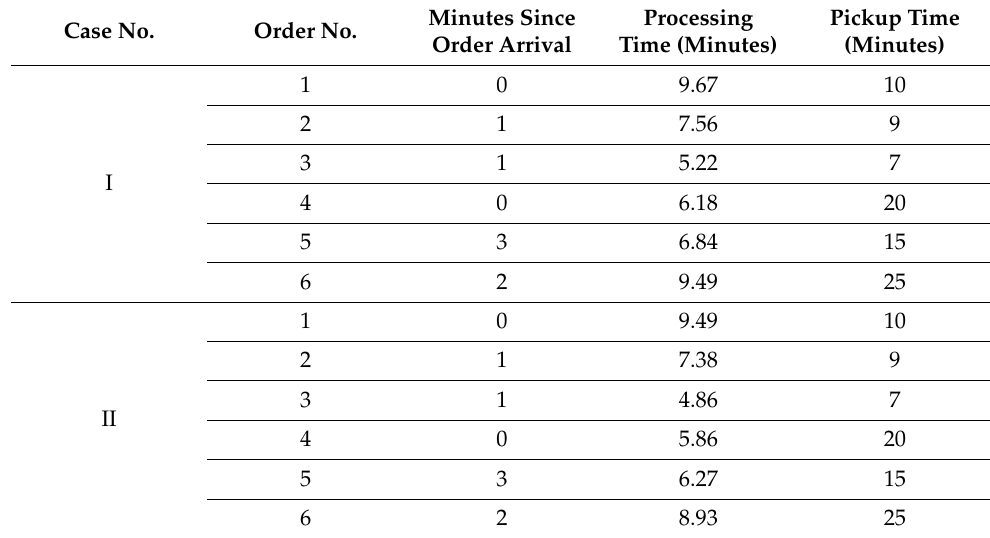
Table 5. The processing and pickup times of the set of orders for Case-I and Case-II. Case No. Order No.